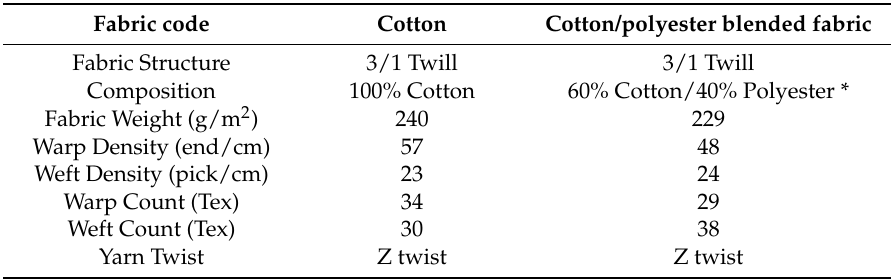
Table 1. Fabric specifications of two woven